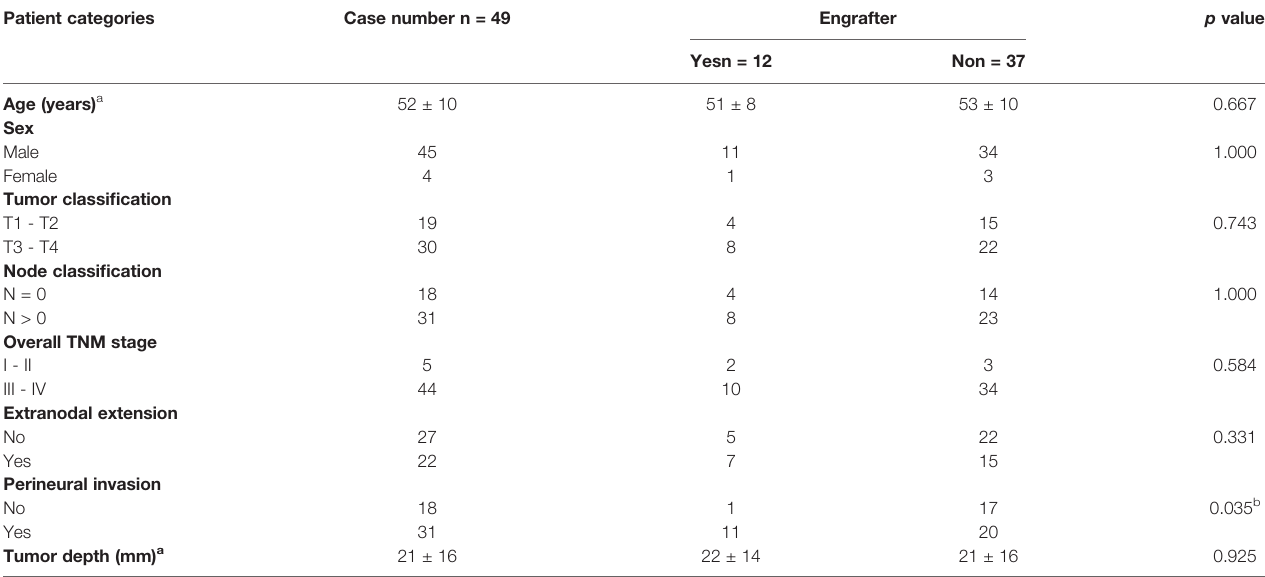
TABLE 1 | Clinical characteristics of total patients (n = 49) in this study. Patient categories